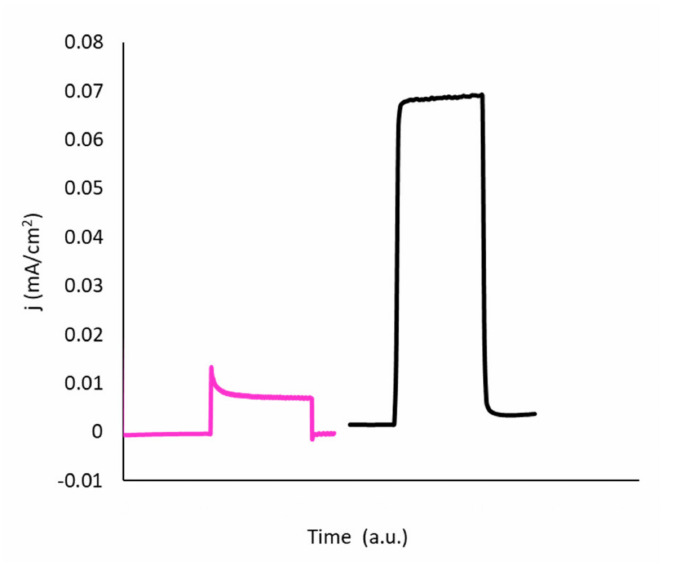
Figure 6. Potentiostatic tests performed with solution containing 0.1 M NaClO 4 at 0.2 ( pink ) and 1.8 V ( black